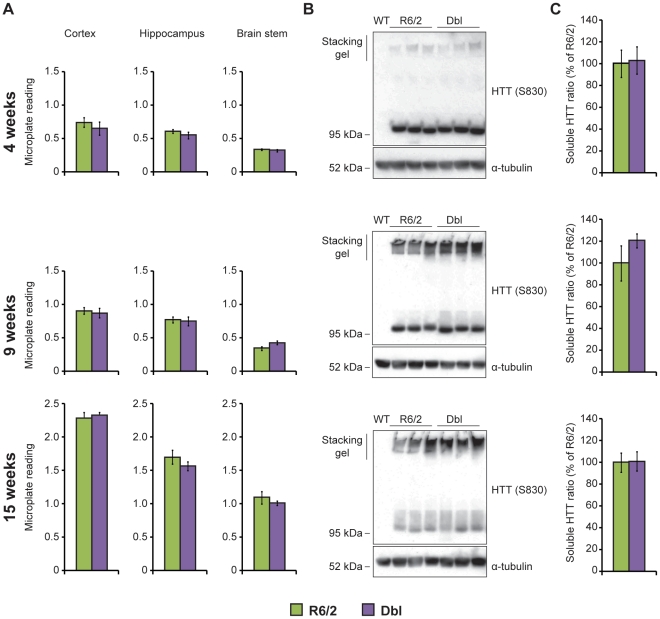
Hdac3 genetic reduction does not reduce HTT aggregation in R6/2 mouse brain.(A) The SEPRION ligand based ELISA assay was used to quantify HTT aggregation in the cortex, hippocampus and brain stem of 4, 9 and 15 week-old mice. The graphs represent the microtitre-plate reading of R6/2 (green) and Dbl (purple) lysates. Background readings obtained with WT and Hdac3 lysates were comparable to water. Aggregation levels augment with age but are not modified by Hdac3 reduction. Error bars correspond to S.E.M. (n>6). (B) Representative western blot of hippocampal lysates at 4, 9 and 15 weeks of age. The aggregated HTT fraction (stacking gel) augments with age whereas the soluble fraction decreases with age. α-tubulin was used as a loading control. (C) Quantification of (B). Soluble HTT is represented as a percentage of the soluble fraction in R6/2. Error bars correspond to S.E.M. (n = 6). The same color code (R6/2 = green; Dbl = purple) is used in (A) and (C).